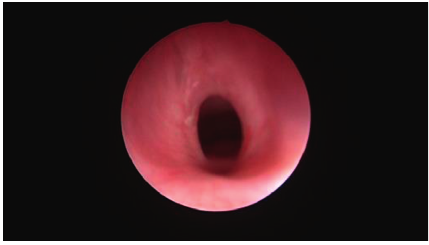
Figure 4: Grade I subglottic stenosis.